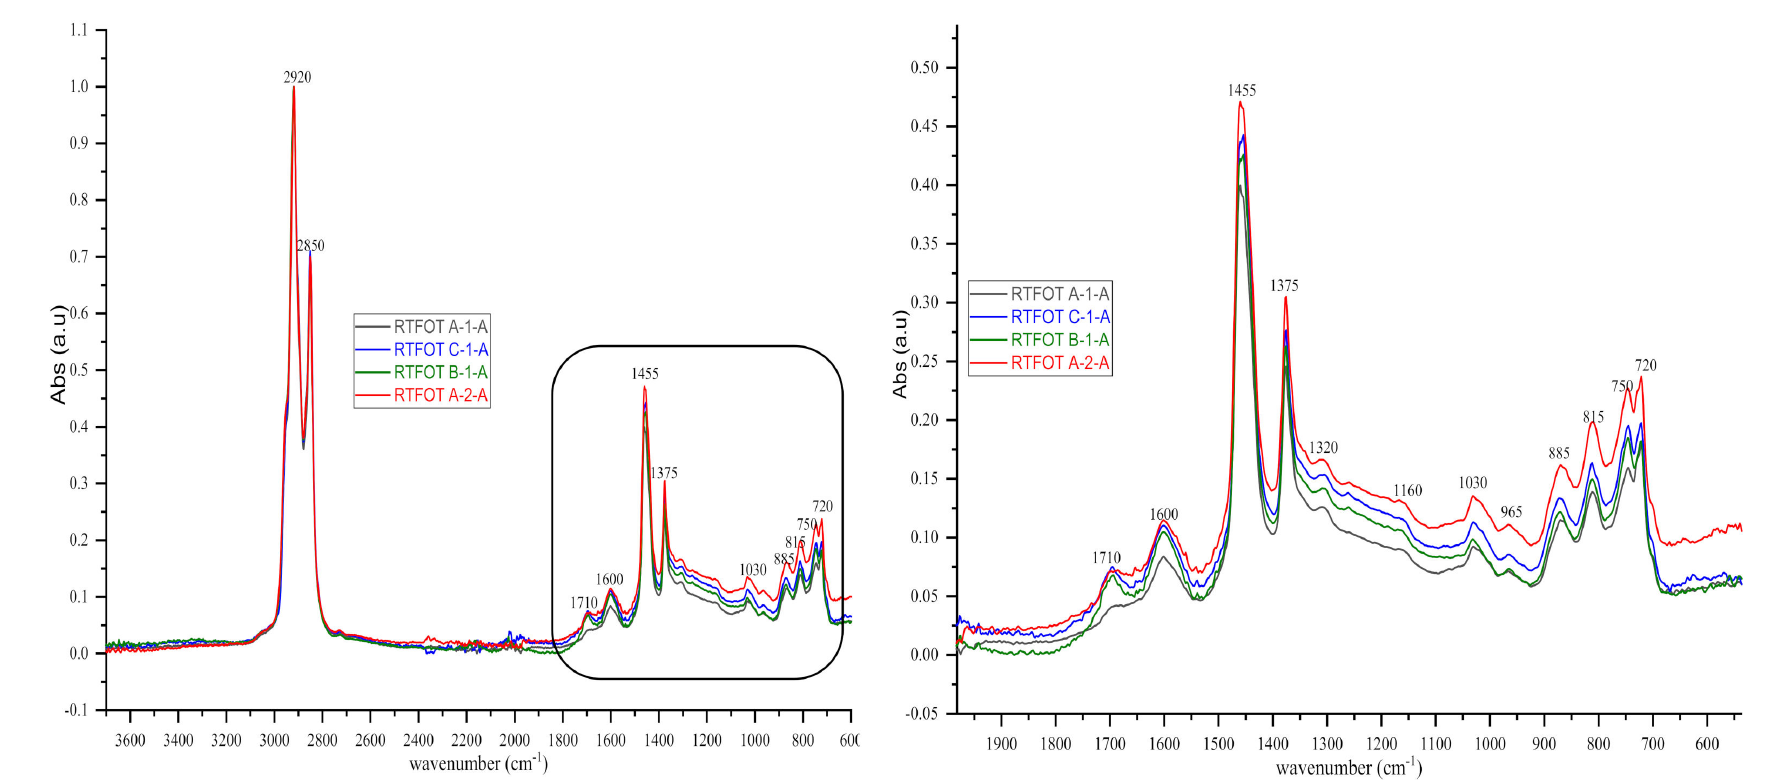
Figure 9. IR spectra (3700–600 cm -1 and 2000–600 cm -1 ) of some bituminous binders after short-term ageing